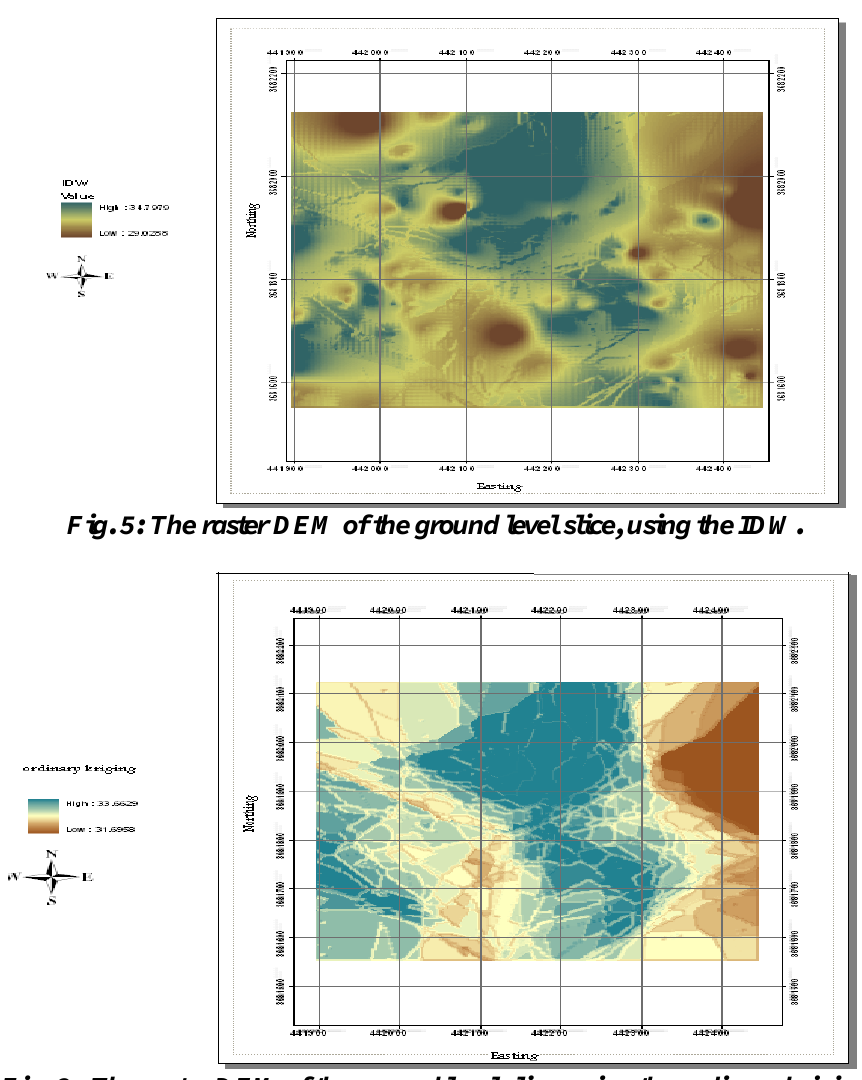
Fig. 6: The raster DEM of the ground level slice, using the ordinary